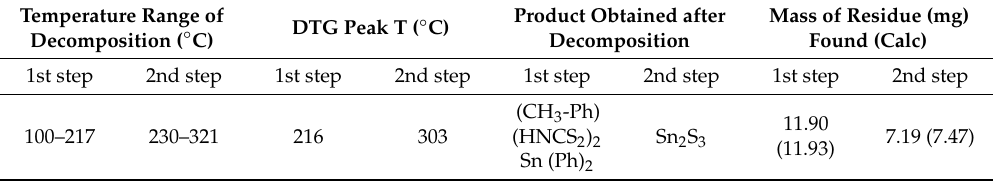
Figure 2. Thermogravimetric and differential thermogravimetric (TG/DTG) curves of diphenyltin(IV) p -methylphenyldithiocarbamate obtained under nitrogen atmosphere (75 mL/min), heating rate 10 °C/min. Table 1. Thermal analysis data of diphenyltin(IV) and p -methylphenyldithiocarbamate.